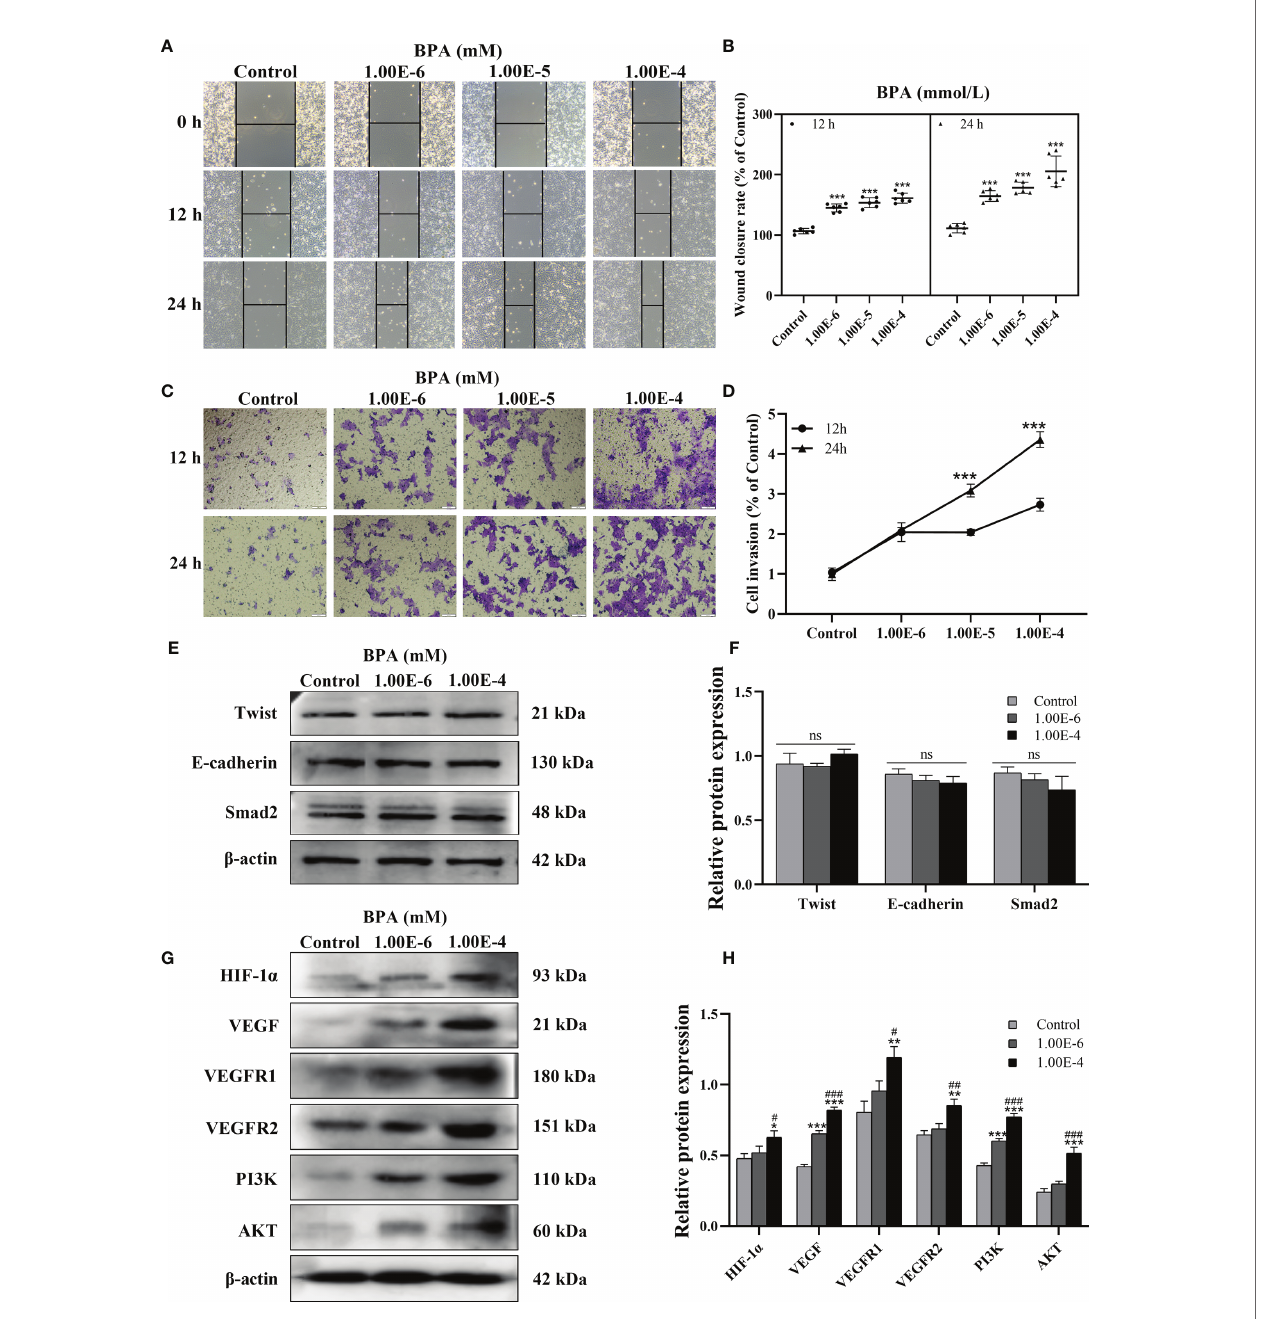
FIGURE 3 | The effects of BPA on invasion, EMT, HIF-1 a /VEGF and PI3K/AKT signaling pathway of DLD1 cells. Representative images of DLD1 cells exposed to BPA for 12 or 24 h in migration (A) and invasion (C) assay. Quantitative analysis of cell migration (B) and invasion (D) rate, n = 6. The protein expression of EMT (E) as well as HIF-1 a / VEGF and PI3K/AKT signaling pathway (G) -related biomarkers in DLD1 cells. Quantitative analysis of expression of EMT (F) , HIF-1 a /VEGF and PI3K/AKT signaling pathway (H) related protein by ImageJ Software, n = 3. Values are expressed as means ± SD, compared with the control group, * p < 0.05, ** p < 0.01, *** p < 0.001. Compared with the 1.00E-6 BPA group, # p < 0.05, ### p < 0.001. ns, no signi fi